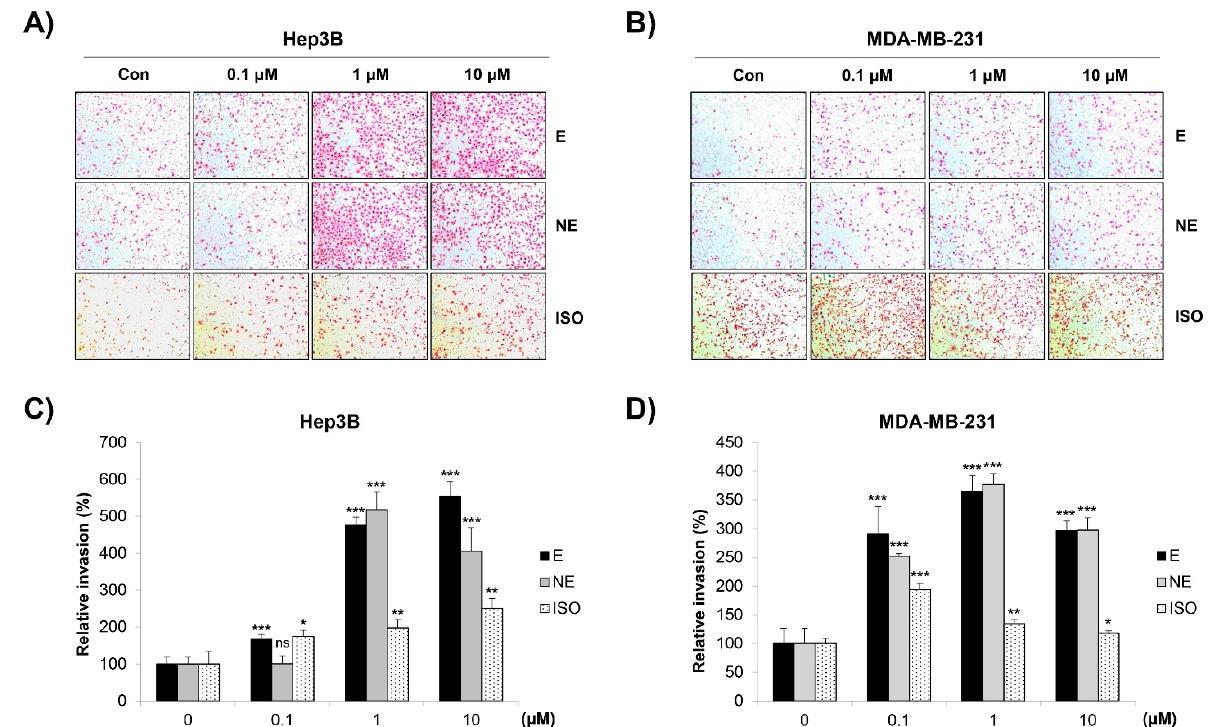
Figure 2. Effect of adrenergic agonists on the invasive capacity of Hep3B and MDA ‐ MB ‐ 231 cells. ( A – D ) Hep3B human HCC cells ( A , C ) and MDA ‐ MB ‐ 231 human BC cells ( B , D ) suspended in se ‐ ( A – D ) Hep3B human HCC cells ( A , C ) and MDA-MB-231 human BC cells ( B , D ) suspended in